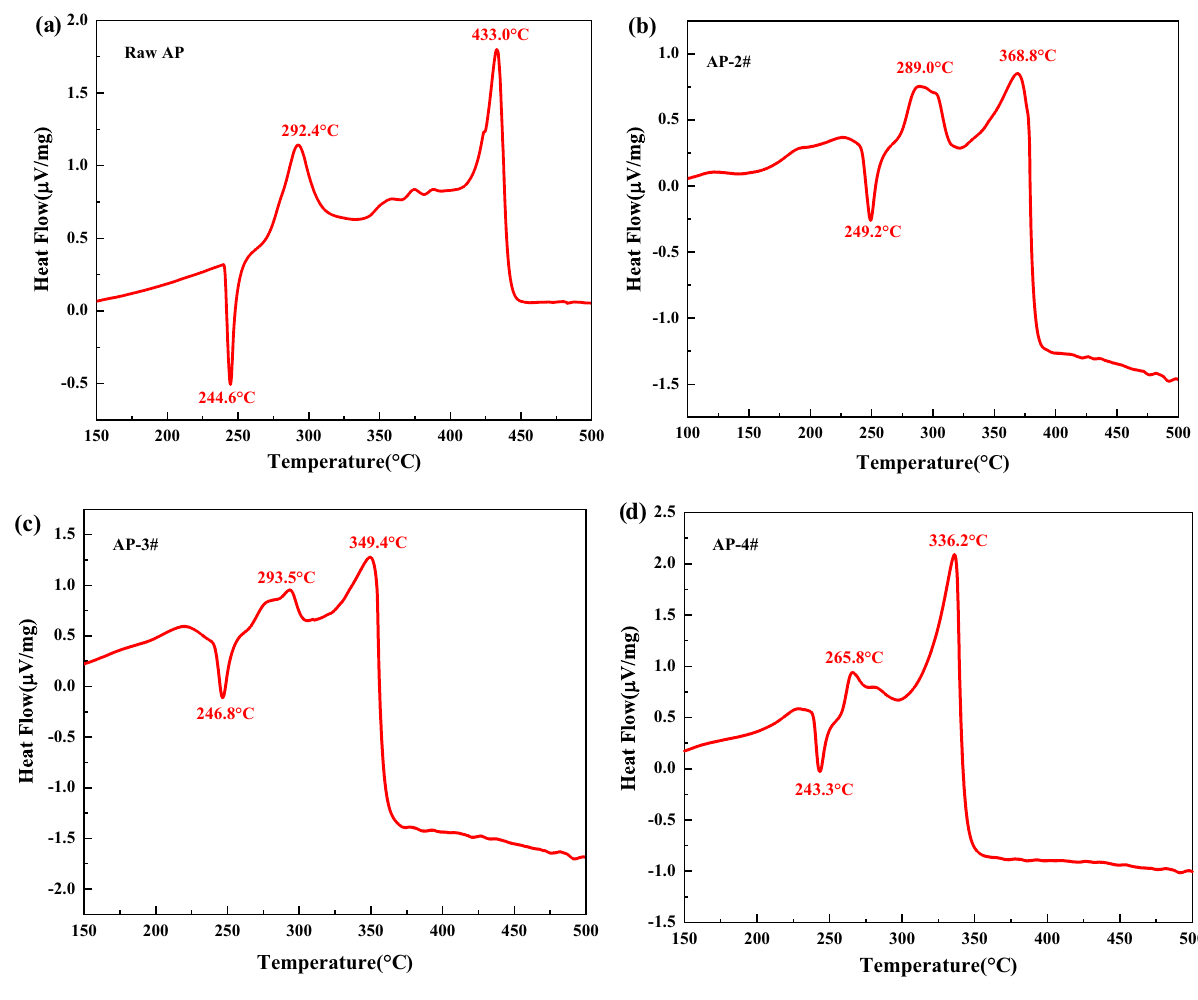
Figure 7. DSC curves of raw AP and laminated AP composite